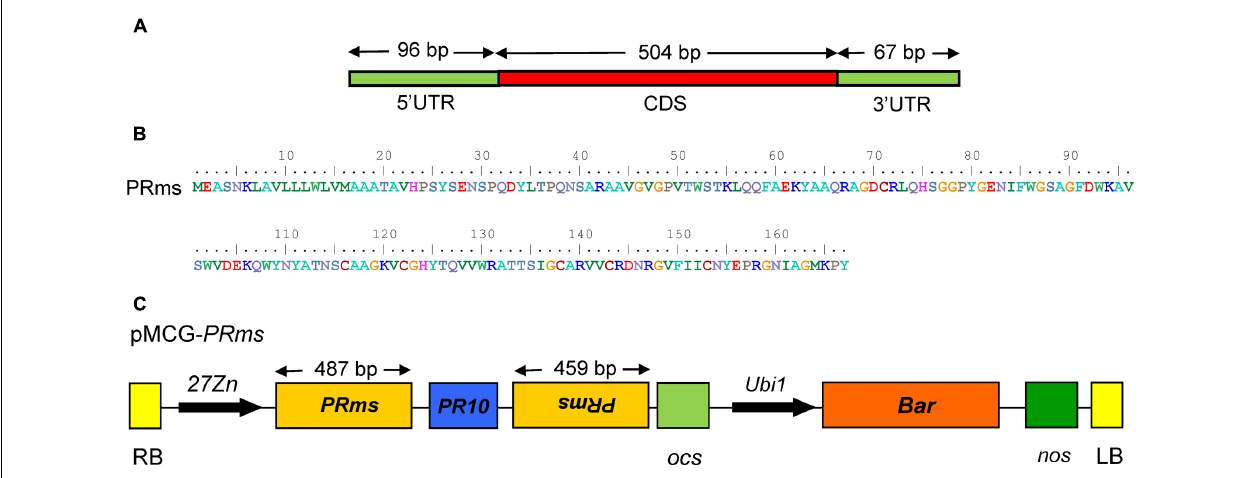
FIGURE 1 | ZmPRms gene and vector construction. (A) Genomic structure of the Zea mays ( Zm ) PRms gene; (B) Amino acid sequence of the ZmPRms gene; (C) Vector diagram of the RNAi construct used for maize transformation to silence the ZmPRms gene (Abbreviations: 27 Zn = maize endosperm-specific promoter, RB = right border, LB = left border, PR10 = intron (maize), Ubi 1 = constitutive promoter, Bar = bialaphos resistance gene, ocs and nos = transcription terminators).